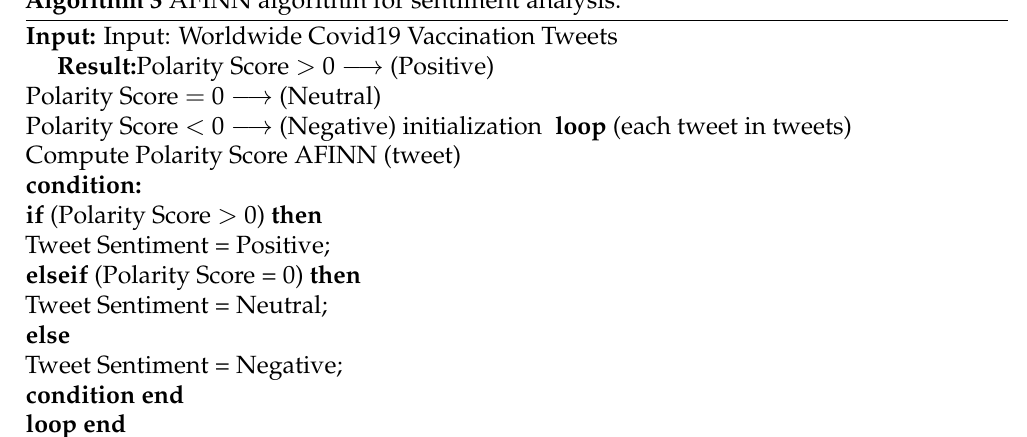
Algorithm 3 AFINN algorithm for sentiment